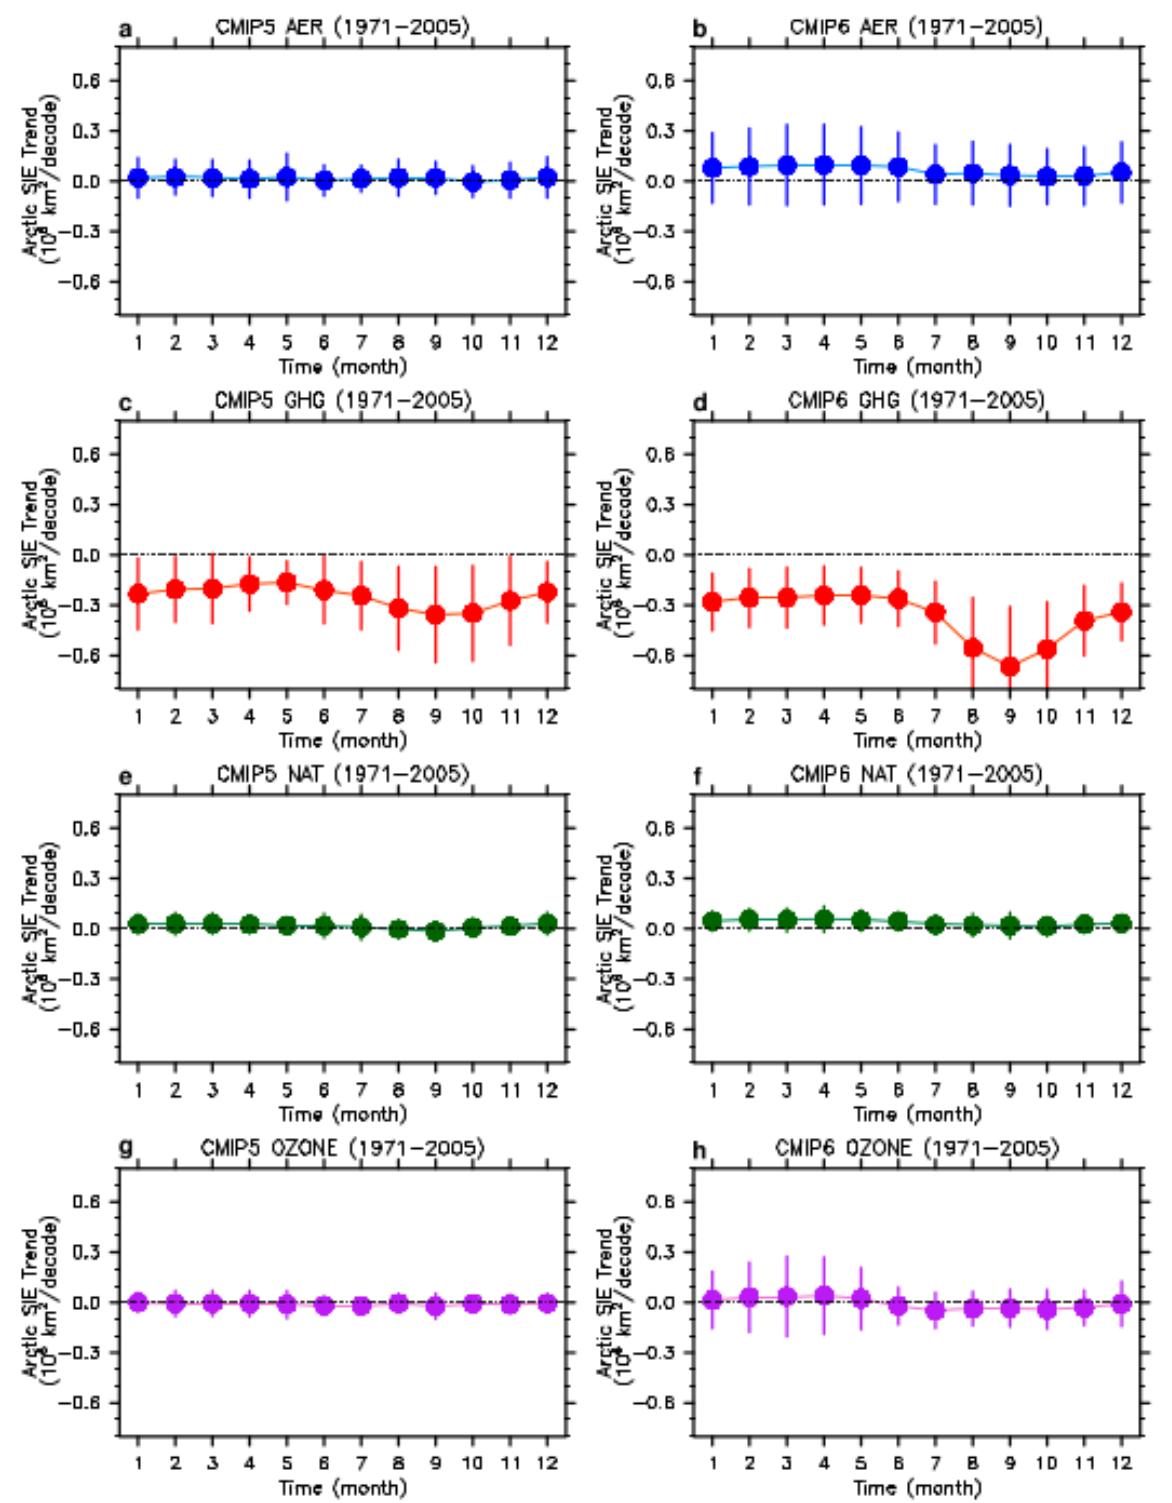
Figure 9. ( a , c , e , g ) Linear trends of monthly mean Arctic sea ice extents from CMIP5 ( a ) AER, ( c ) GHG, ( e ) NAT, and ( g ) OZONE simulations over 1971–2005. Dots indicate MMMs and bars indicate inter-model spreads. ( b , d , f , h ) Same as ( a , c , e , g ) but for